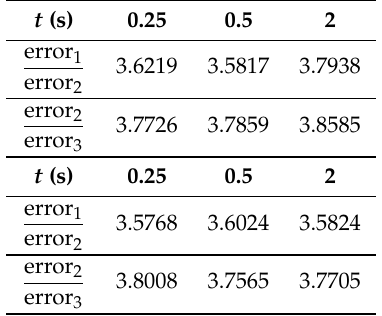
Table 4. Convergence order computed in l 2 and l ∞ norms for the real parts,